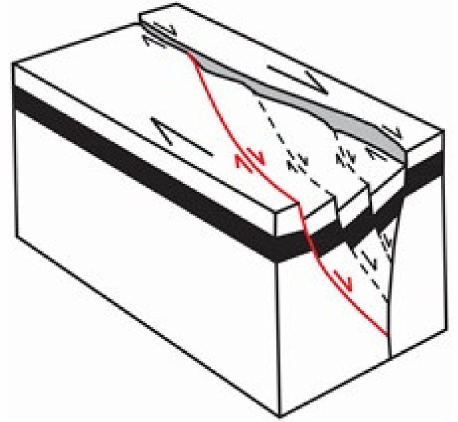
Figure 10. Block diagram illustrating the structural evolution of the southern termination of the Anar